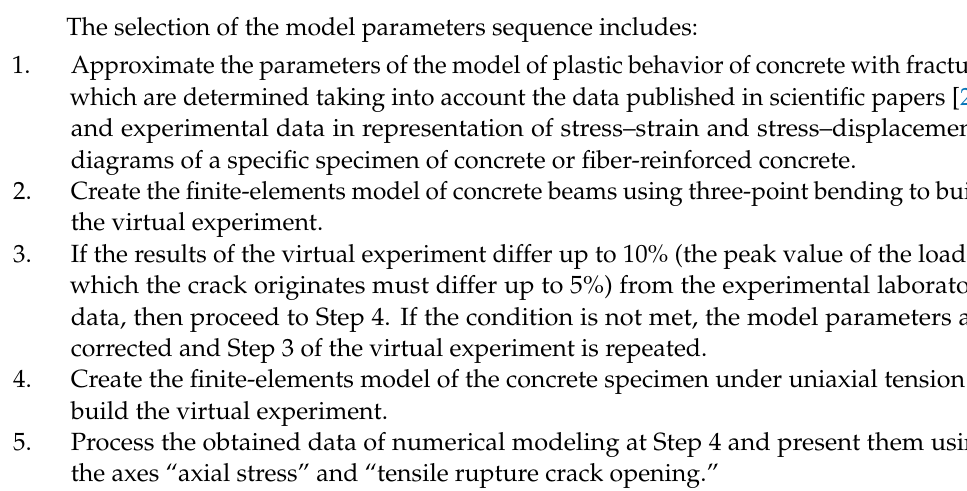
Figure 5. Flow chart of the sequence of selection damaged concrete plasticity model parameters.